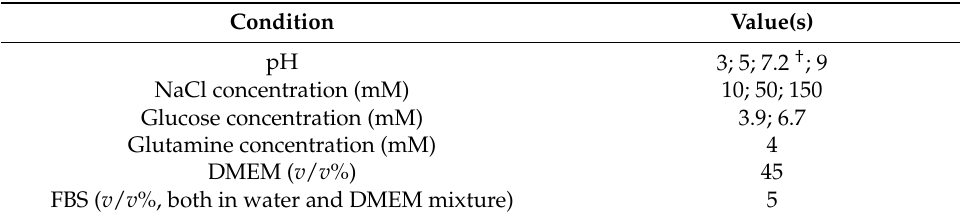
Table 1. List of applied biorelevant conditions; ( † ) represents the reference point for the measurements. All samples were measured at 37 ◦ C, pH~7.2, with a 10 mM NaCl electrolyte background unless otherwise